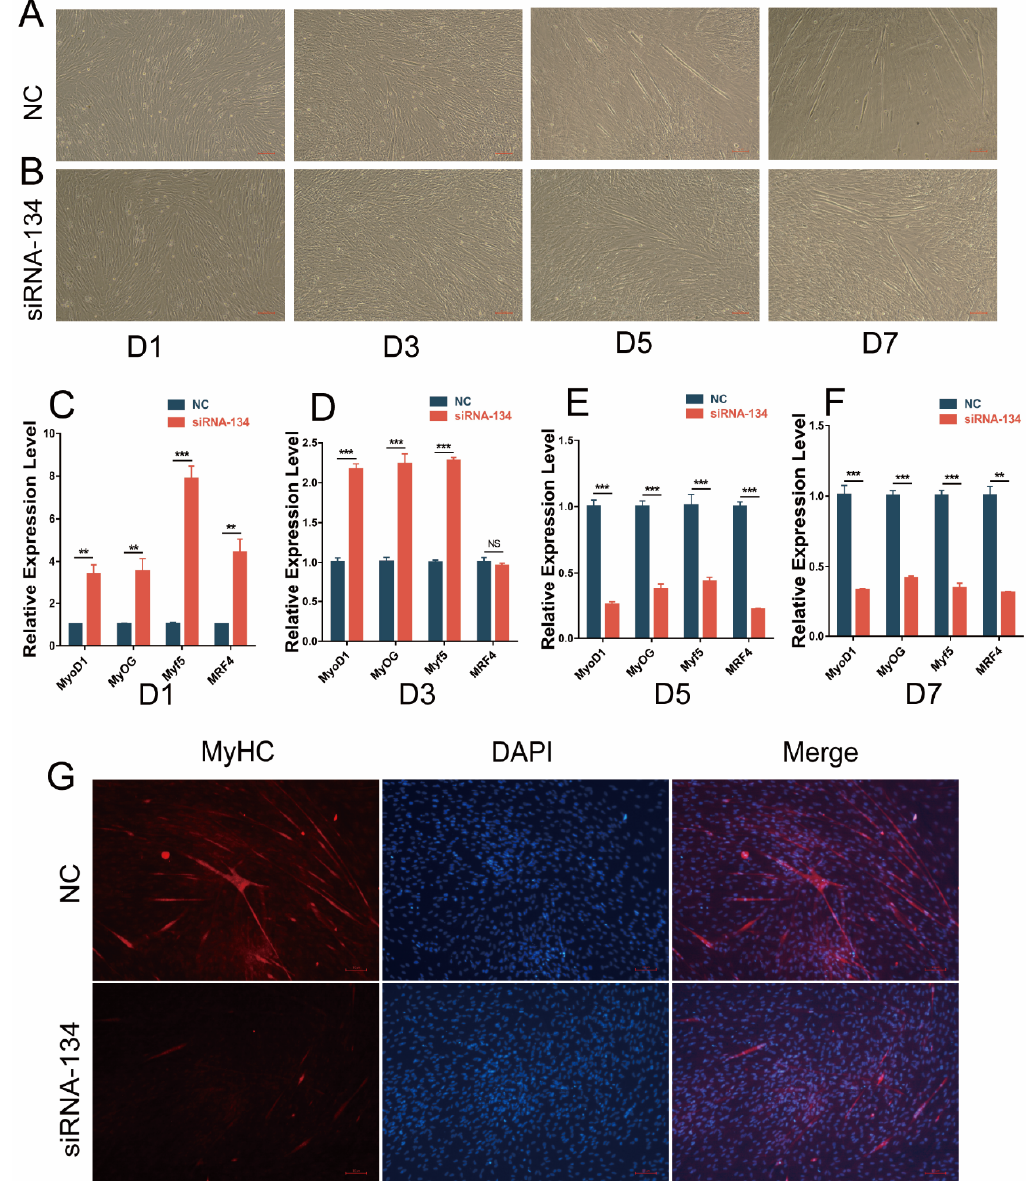
Figure 5. Effects of LAP3 knockdown on embryonic myoblast differentiation. ( A , B ) The observation of embryonic myoblasts in bright field at 1st, 3rd, 5th, and 7th day (D1, D3, D5, and D7) of differentiation transfected with siRNA-LAP3 or control using a fluorescence inverted microscope (100×). ( C – F ) The expression levels of MyoD1 , MyF5 , MyoG , and MRF4 in embryonic myoblasts transfected with siRNA-LAP3 or control at 1st ( C ), 3rd ( D ), 5th ( E ), and 7th ( F ) day (D1, D3, D5, and D7) of differentiation using RT-PCR. ( G ) Immunofluorescence staining of embryonic myoblasts trans- fected with siRNA-LAP3 or control using a fluorescence inverted microscope (100×). ** p < 0.01, or *** p < 0.001, extremely significant difference; NS p > 0.05, no difference according to Student’s t -test; data are shown as mean ± SEM, n = 3 biological replicates.